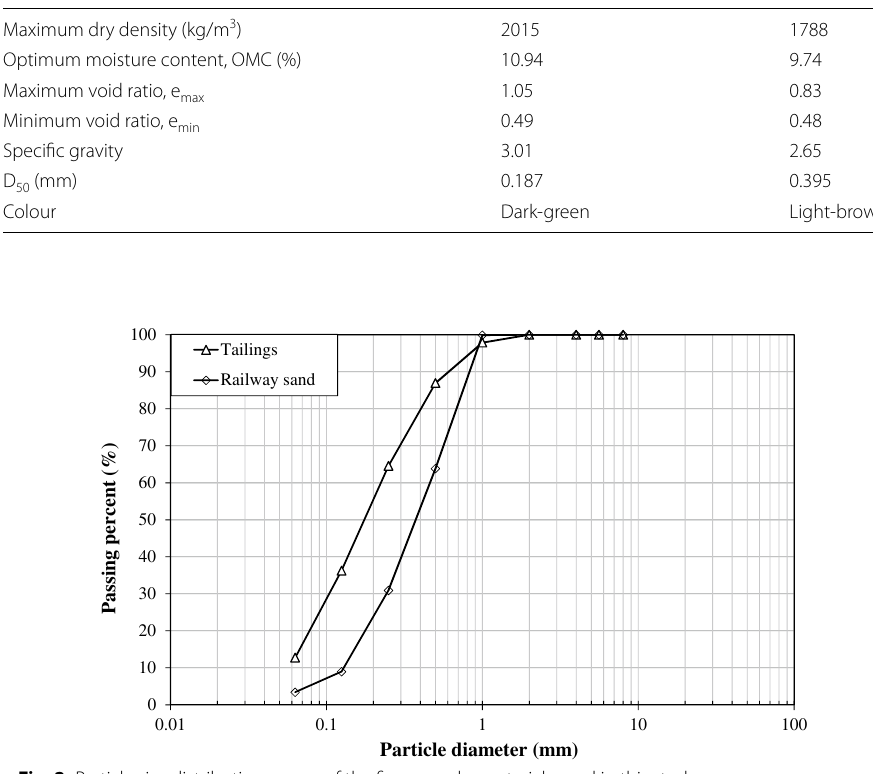
Table 1 Physical properties of the granular materials used in this study Properties